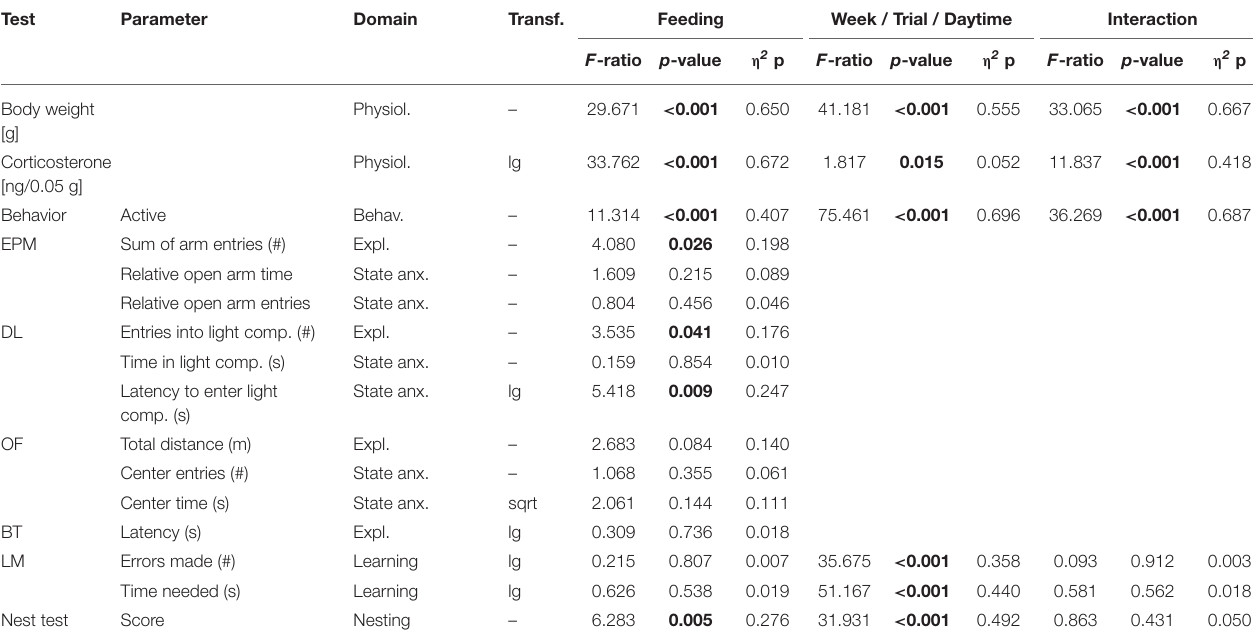
TABLE 3 | Statistics experiment 2: Presented are interaction and main effects of “time”/“trial”/“daytime” and “feeding routine” ( F -ratios, p -values, and estimated effect sizes) on weight, fecal corticosterone metabolite (FCM) concentrations, behavior in the home cage and on individual common parameters that were assessed in the Elevated Plus Maze Test (EPM), the Dark-Light Test (DL), the Open Field Test (OF), the Barrier Cage Test (BT), the Labyrinth-Maze Test (LM), and the Nest Test (NT).